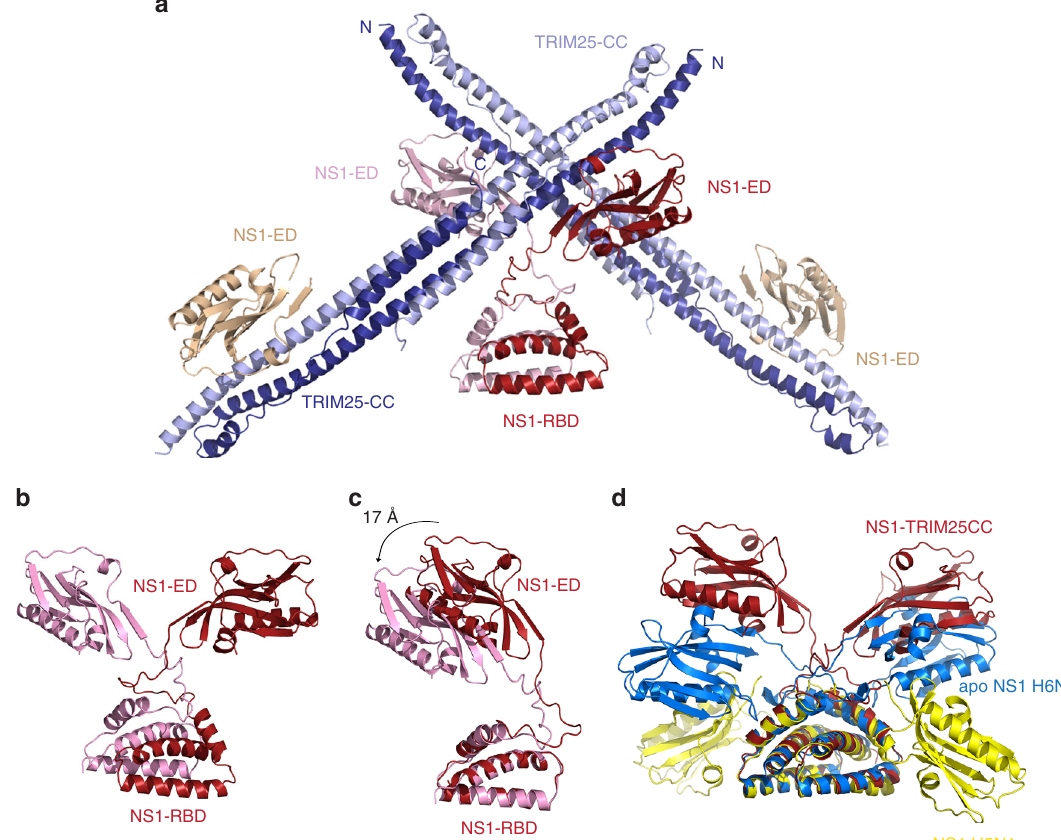
Fig. 3 Crystal structure of NS1-FL in complex with TRIM25-CC. a The asymmetric unit contains four molecules of each, NS1-FL (R38A/K41A/W187A) and TRIM25-CC, with electron density visible for 2 TRIM25-CC dimers (in dark and light blue), 2 NS1-FL (in red and pink) and 2 NS1-ED domains (in wheat). b NS1-FL resembles the shape of letter Y, with the RBD forming a homodimeric 6-helical structure and the effector domains extending outwards without making contact with each other or the RBDs. c Structural alignment of dimeric NS1-FL from a using the RBD for the overlap shows that the two protomers are not in identical positions, with one ED being shifted by 17 Å in relation to the other. d Structural alignment of NS1 shown in b (in red) with the other two available apo-NS1-FL structures (A/Vietnam/1203/2004(H5N1), R38A/K41A) shown in yellow (PDB: 3F5T) and (A/MN/993/1980(H6N6) R38A/K41A) shown in blue (PDB: 4OPH) reveals structural fl exibility owing to the linker region (LR) of